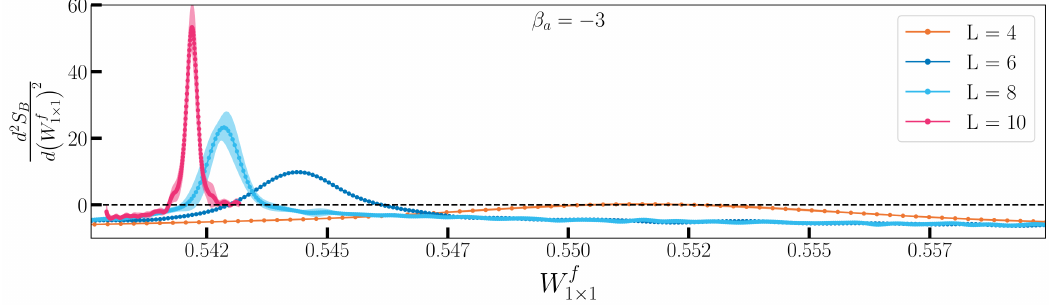
Figure 8 . Second derivative of the entropy with respect to W f and different lattice sizes. The dependence on the lattice size becomes even more pronounced than in the case of the first derivative. The colored region around the markers is an estimate of the error based on independent measurements.